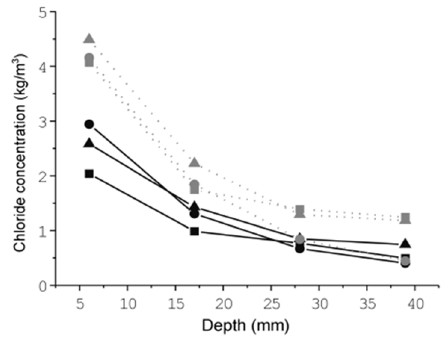
Figure 7. Chloride profiling of concrete according to concrete cover depth.